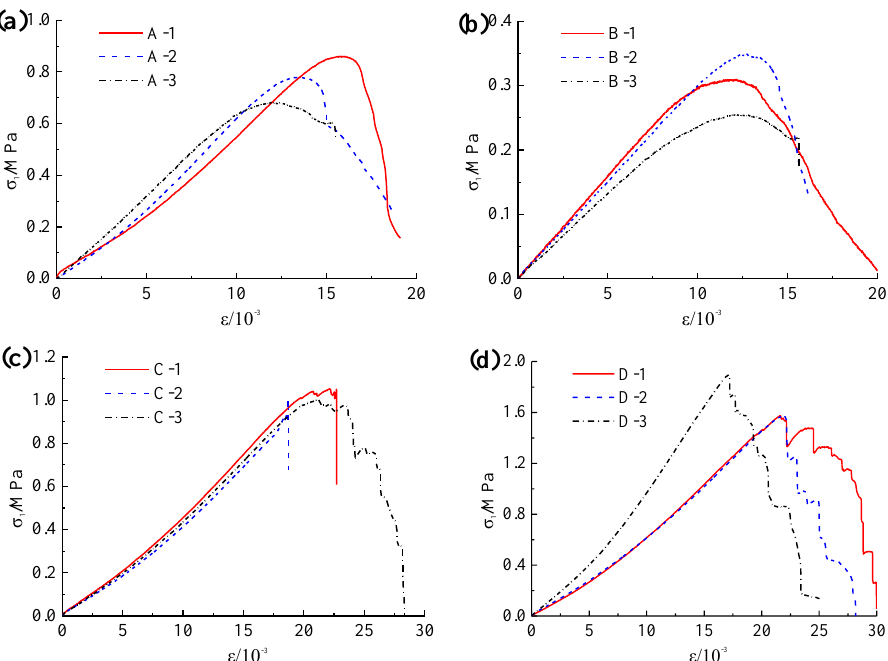
Figure 5. Stress–strain curves of the uniaxial compression of briquettes with different particle sizes: ( a ) group A, ( b ) group B, ( c ) group C and ( d ) group D.